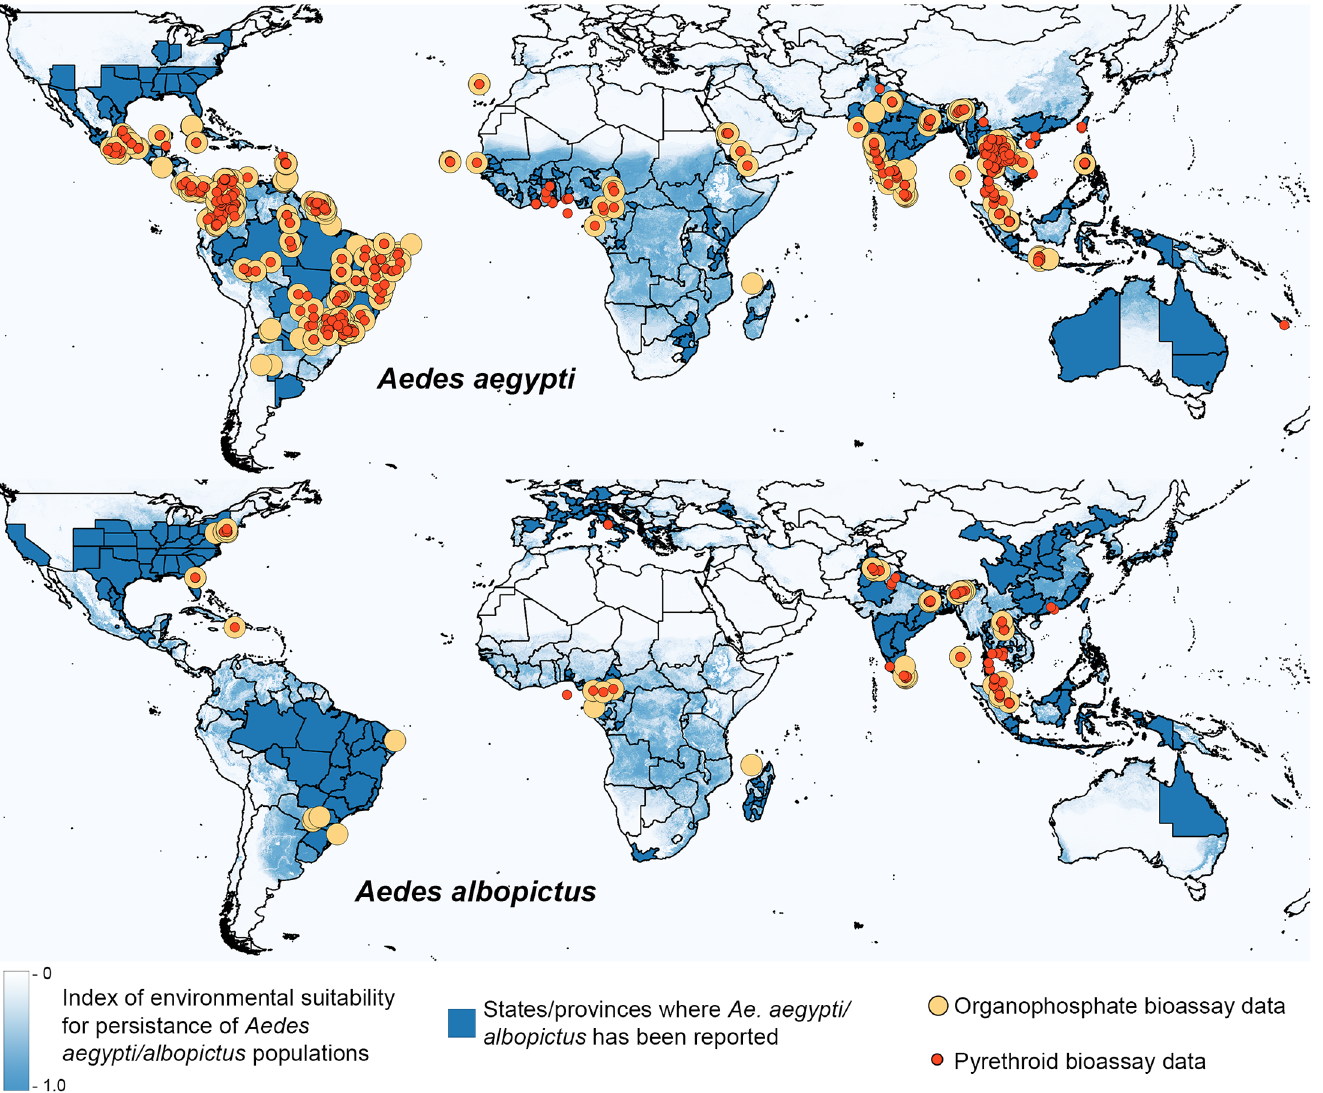
Fig 1. Locations of bioassay data for the organophosphates and pyrethroids, 2006to 2015. Locationsof populationsthat have beenbioassayed (susceptibility and dose response, adult and larval) are shown for both insecticideclasses, overlaid on maps of environmental suitability for Ae . aegypti and Ae . albopictus from Kraemer et al. (2015) eLife, 4: